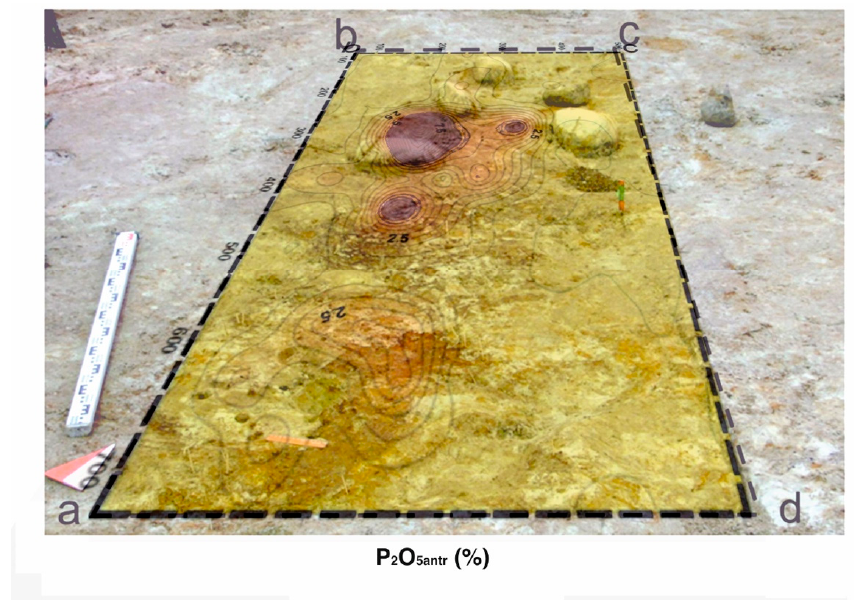
Figure 4. Distribution of P 2 O 5antr (%) on the surface of the burial layer at the Okhta 1 site [38], designed by M.Kulkova, a, b, c, d—burial area.